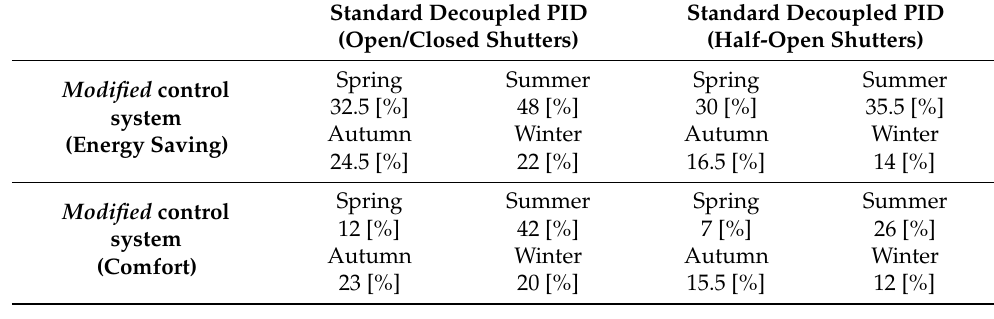
Table 14. Energy saving results: comparison between the modified control system and the standard decoupled PID controllers.